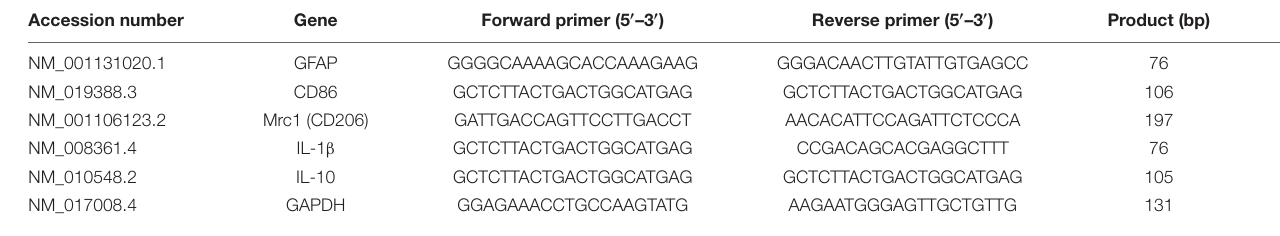
TABLE 1 | List of